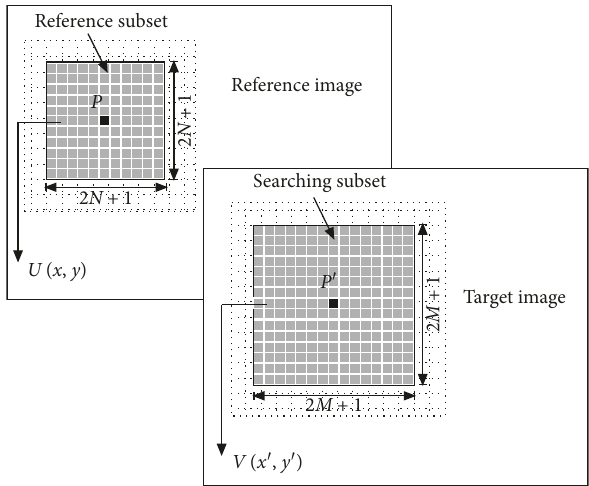
Figure 3: Schematic of the DIC calculation.